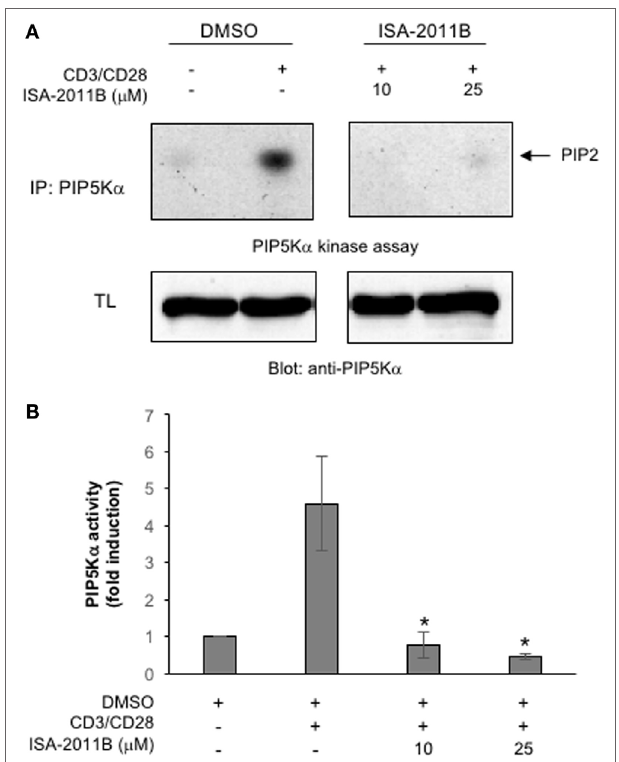
FigUre 1 | isa-2011B inhibits phosphatidylinositol 4-phosphate 5-kinase (PiP5K) α lipid-kinase activity in primary T cells . (a) Primary T cells from healthy donors (HD) were treated for 6 h with DMSO or the indicated concentrations of ISA-2011B and then unstimulated (ctr) or stimulated for 5 min with saturating concentration of anti-CD3 (5 µg/ml) plus anti-CD28 Abs crosslinked with goat anti-mouse (20 µg/ml). PIP5K kinase assays were performed on anti-PIP5K α immunoprecipitations and the reaction products were subjected to thin-layer chromatography followed by autoradiography (upper panel). An equal amount of cell lysate was analyzed for PIP5K α content by Western blotting (lower panel). (B) Fold inductions were quantified by densitometric analysis and normalized to PIP5K α levels. Bars show the mean ± SD of two experiments. Asterisks (*) indicate P < 0.05 calculated by Student’s t